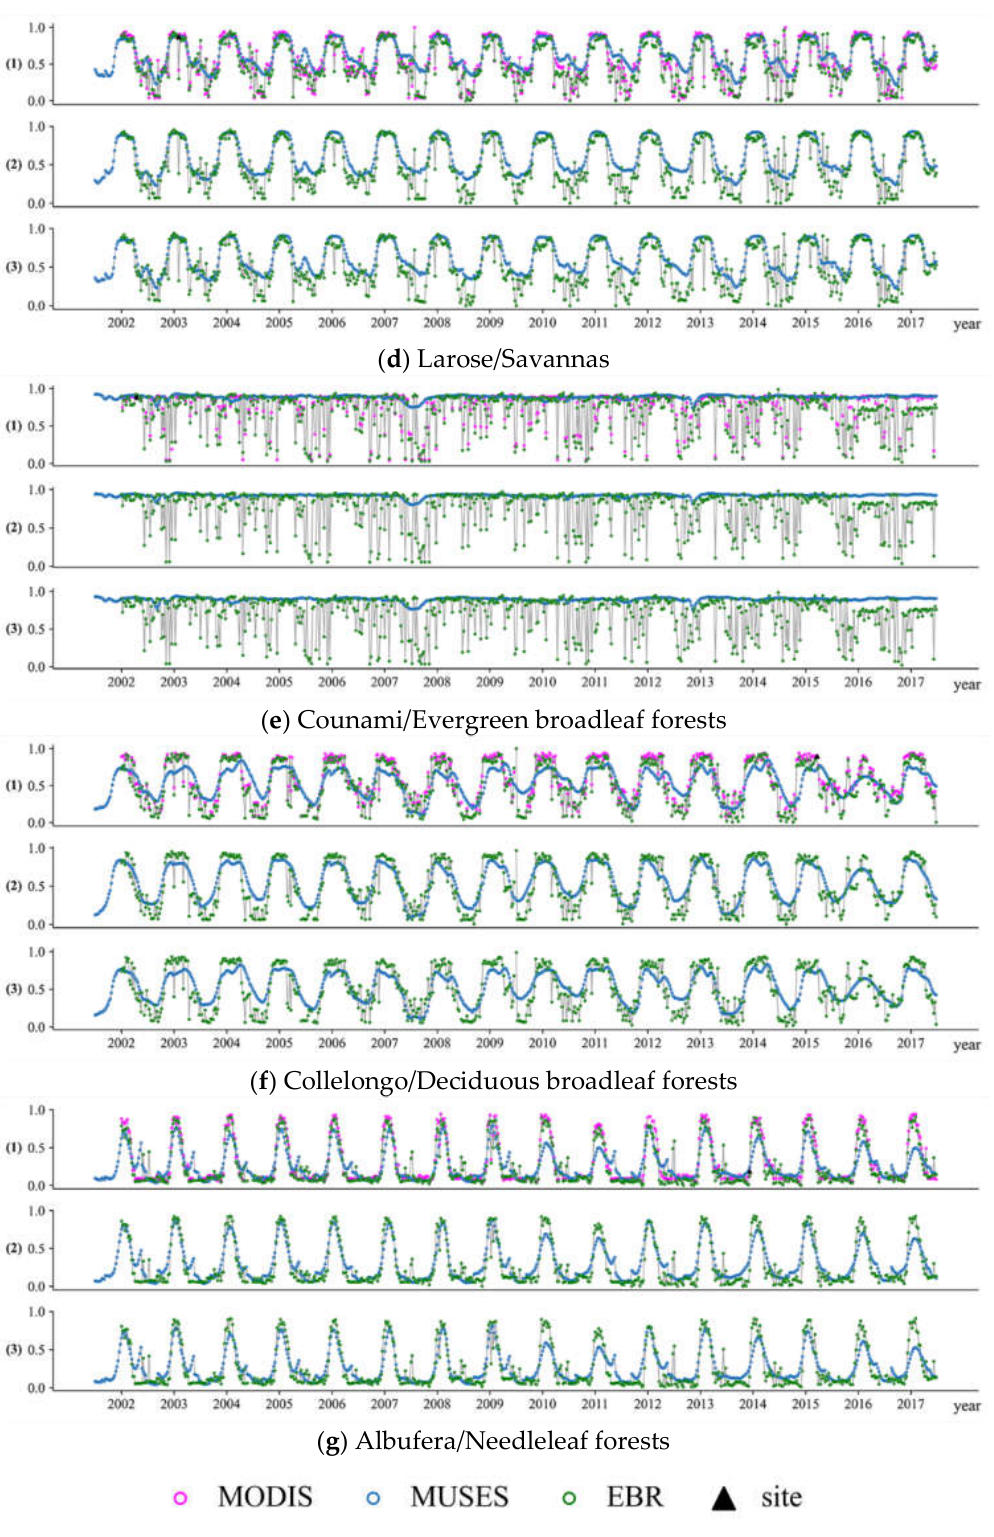
Figure 6. Time series of the black-sky (1), white-sky (2) and blue-sky (3) FAPAR values from the MODIS, MUSES and EBR products for ( a ) Zhangbei, ( b ) Urgons, ( c ) 25de_Mayo, ( d ) Larose, ( e ) Counami, ( f ) Collelongo and ( g ) Albufera sites from 2002 to 2017.